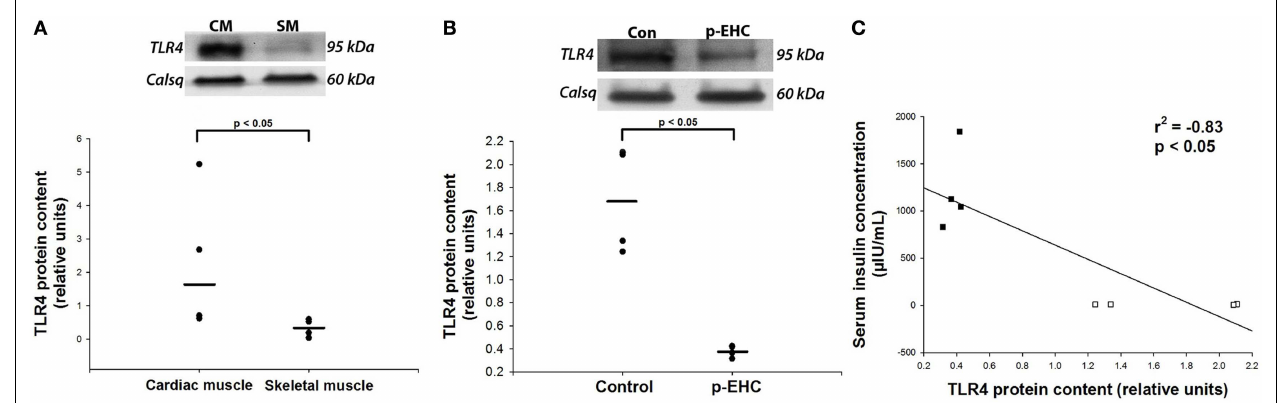
decreased ( p < 0.05) in horses treated with a prolonged, euglycemic, hyperinsulinemic clamp (p-EHC), compared with control horses. (C) Serum insulin concentration negatively correlates (Rsqr =− 0.83) with myocardial TLR4 protein content in horses treated with a p-EHC ( (cid:4) ) and control horses ( (cid:3) ).